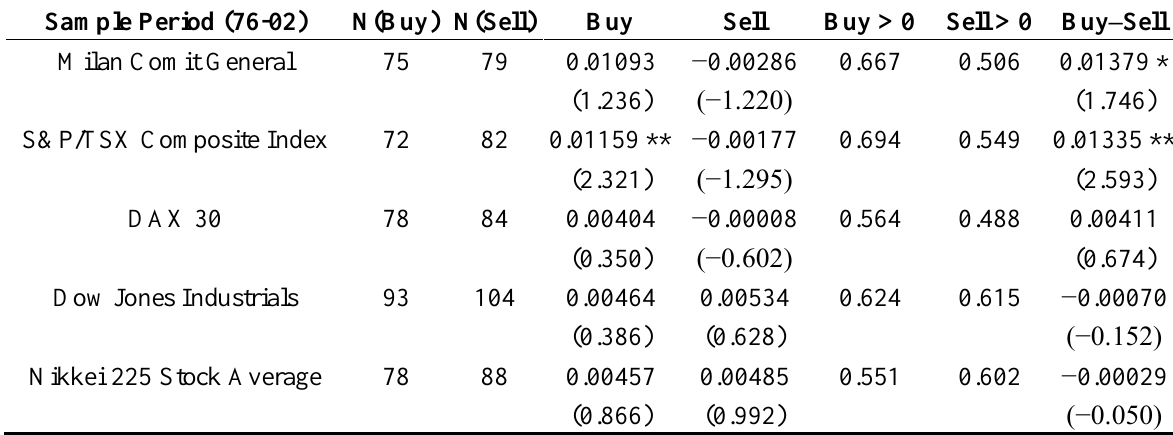
Table 2A. Average ten-day returns from MACD (12,26,0).